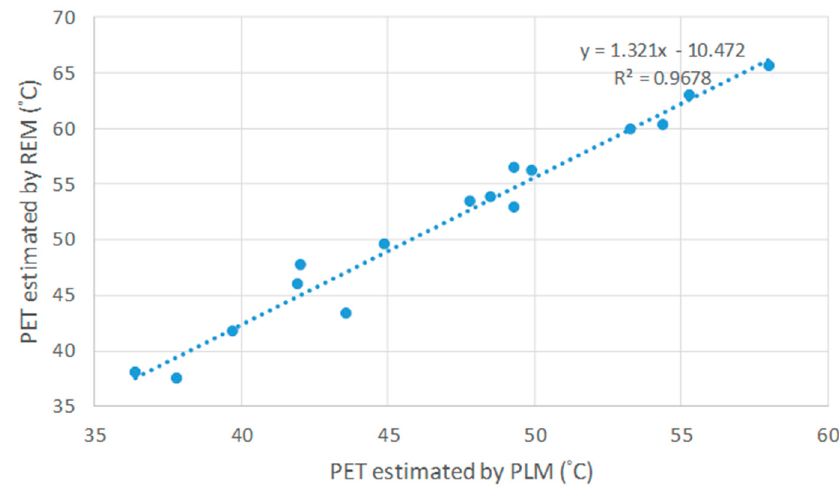
Figure 8. The correlation result of PET calculated by PLM and REM.